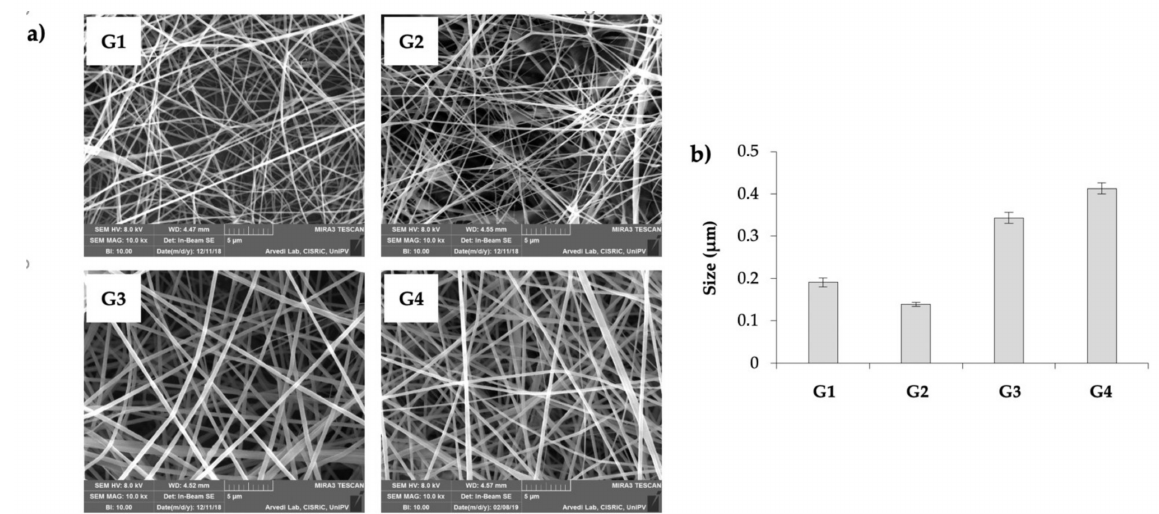
Figure 1. SEM micrographs ( a ) and size (mean values ± s.e.; n = 30) ( b ) of the electrospun nanofibers obtained from the different polymeric solutions (20 cm distance; 20 kV voltage). One-way ANOVA; post hoc Scheff é test ( p ≤ 0.05): G1 vs. G3, G4; G2 vs. G3, G4; G3 vs. G4.